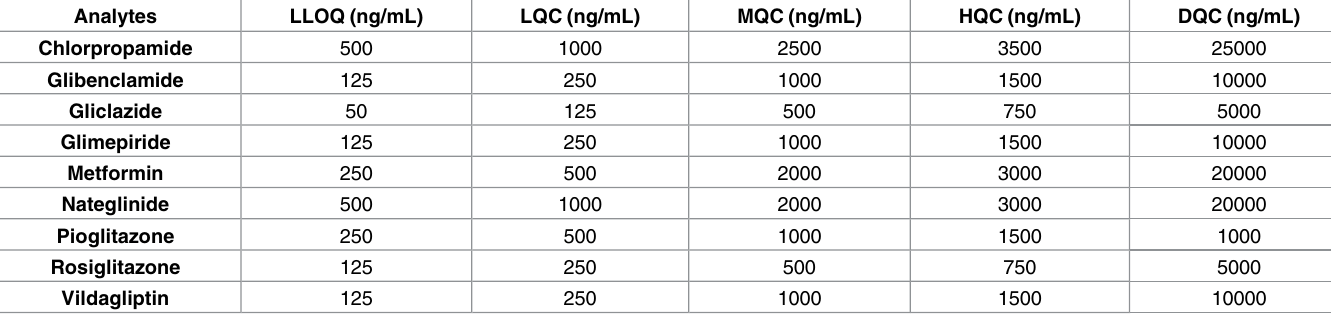
Table 1. Quality control levels used to evaluate method